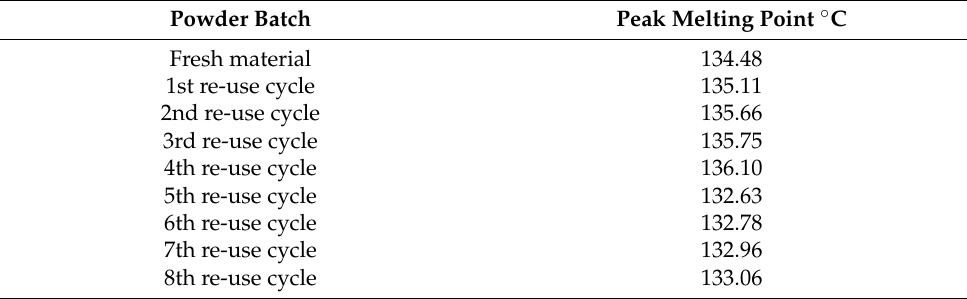
Table 5. Changes in melting point of Laser PP CP 75 after eight re-use